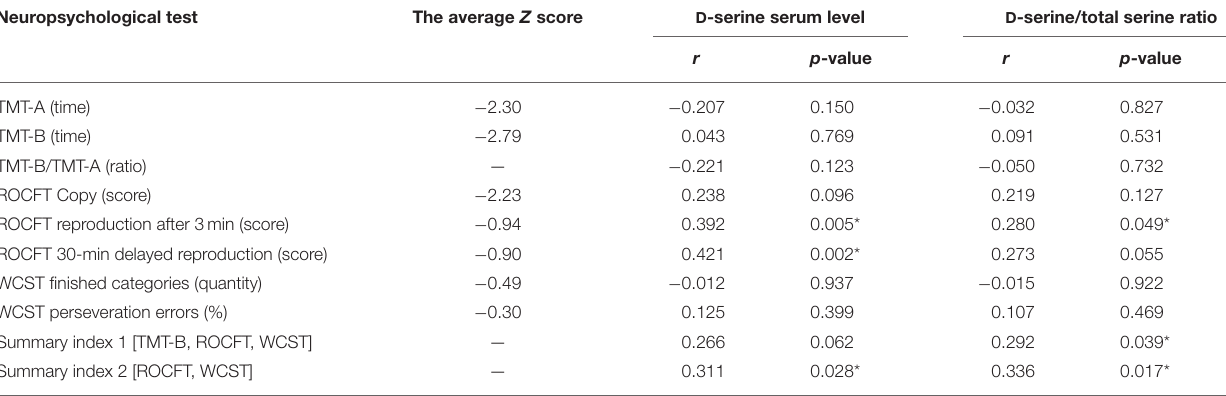
TABLE 5 | The average Z scores from the particular neuropsychological tests, summary index 1 (TMT-B, ROCFT, and WCST) and summary index 2 (ROCFT, WCST) correlations with D -serine serum levels and D -serine/total serine ratio in patients with schizophrenia ( n = 50). Neuropsychological test The average Z score D -serine serum level D -serine/total serine ratio